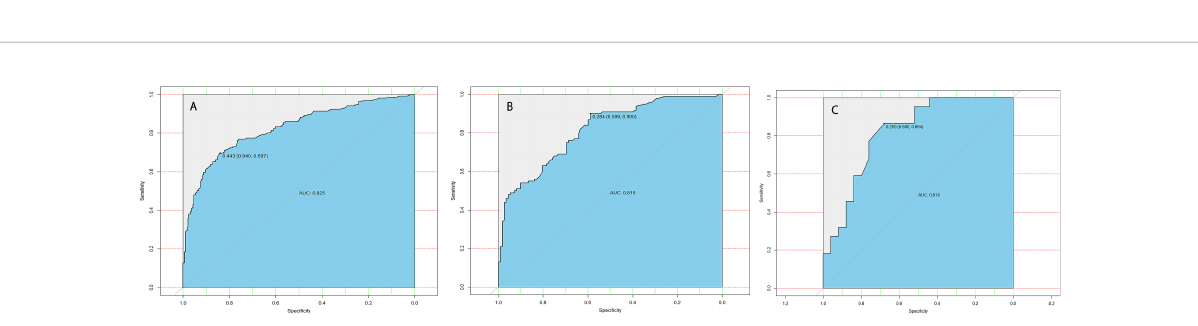
FIGURE 3 | (A) Calibration curve of the nomogram for predicting LLNM in MTC patients for training set. (B) Calibration curve of the nomogram for predicting LLNM in MTC patients for the internal testing set.